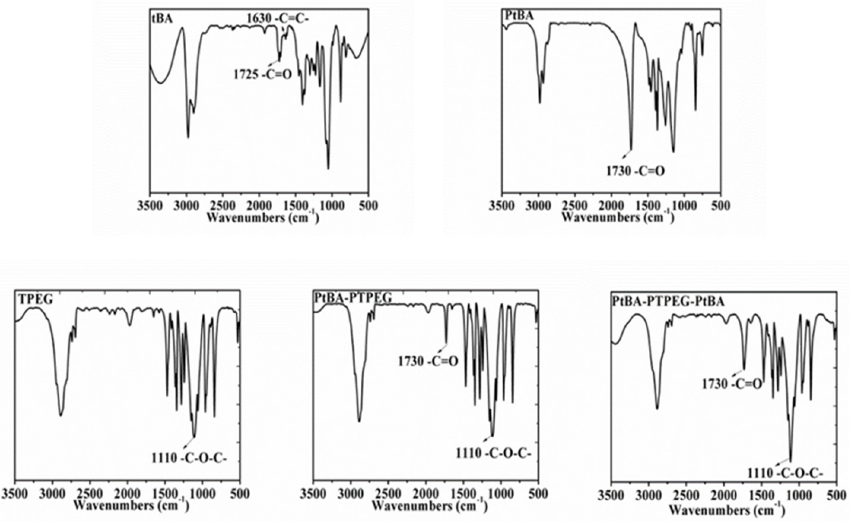
Figure 1. FTIR spectra of tBA, PtBA, TPEG, PtBA-PTPEG and PtBA-PTPEG-PtBA. Figure 2 shows 1 HNMR spectra of TPEG, PtBA, PtBA − PTPEG and PtBA − PTPEG − PtBA. The signal at δ = 1.5 ppm in curve of PtBA was characteristic of tBA. Curve of TPEG showed the signal of − CH 2 − CH 2 − O − at δ = 3.50–3.65 ppm. Curves of PtBA − PTPEG and PtBA − PTPEG − PtBA also have the signals of δ = 1.5 ppm and δ = 3.50– 3.65 ppm. At the same time, the acid − to − ether ratio, obtained by calculation after integrat ‐ ing the peak area on the curve at δ = 1.5 ppm and δ = 3.50–3.65 ppm, is in line with expec ‐ tations. The 1HNMR spectra of Figure 2c,d represent PtBA − PTPEG and PtBA − PTPEG − PtBA were synthesized successfully, because another new peak appeared sized macromolecules, which were in accordance with the designed structure.